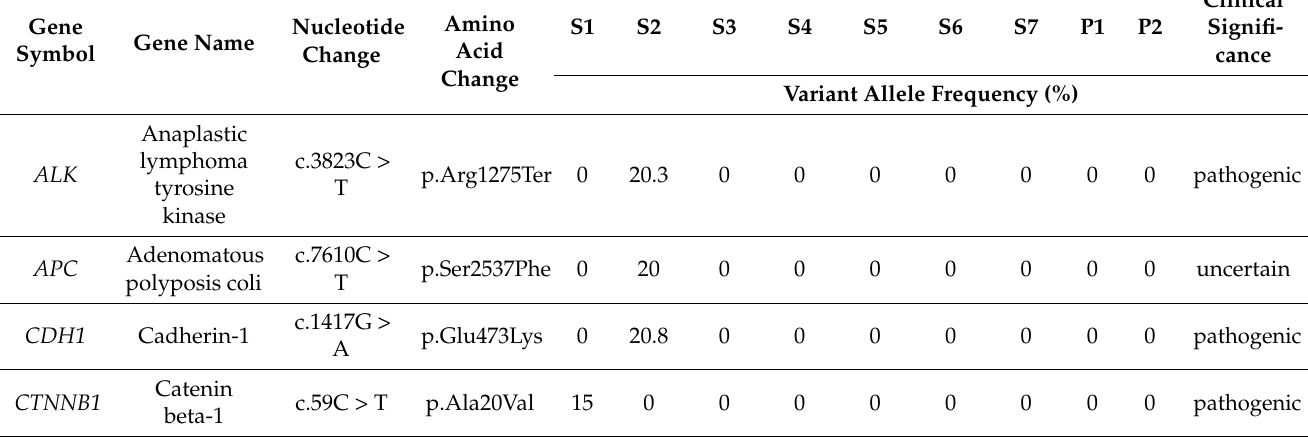
Table 2. Somatic gene mutations, sequence variants and their frequencies determined by next-generation sequencing (S1–S7: patient’s samples, P1 and P2: parents’ samples). Clinical significance was determined according to the COSMIC